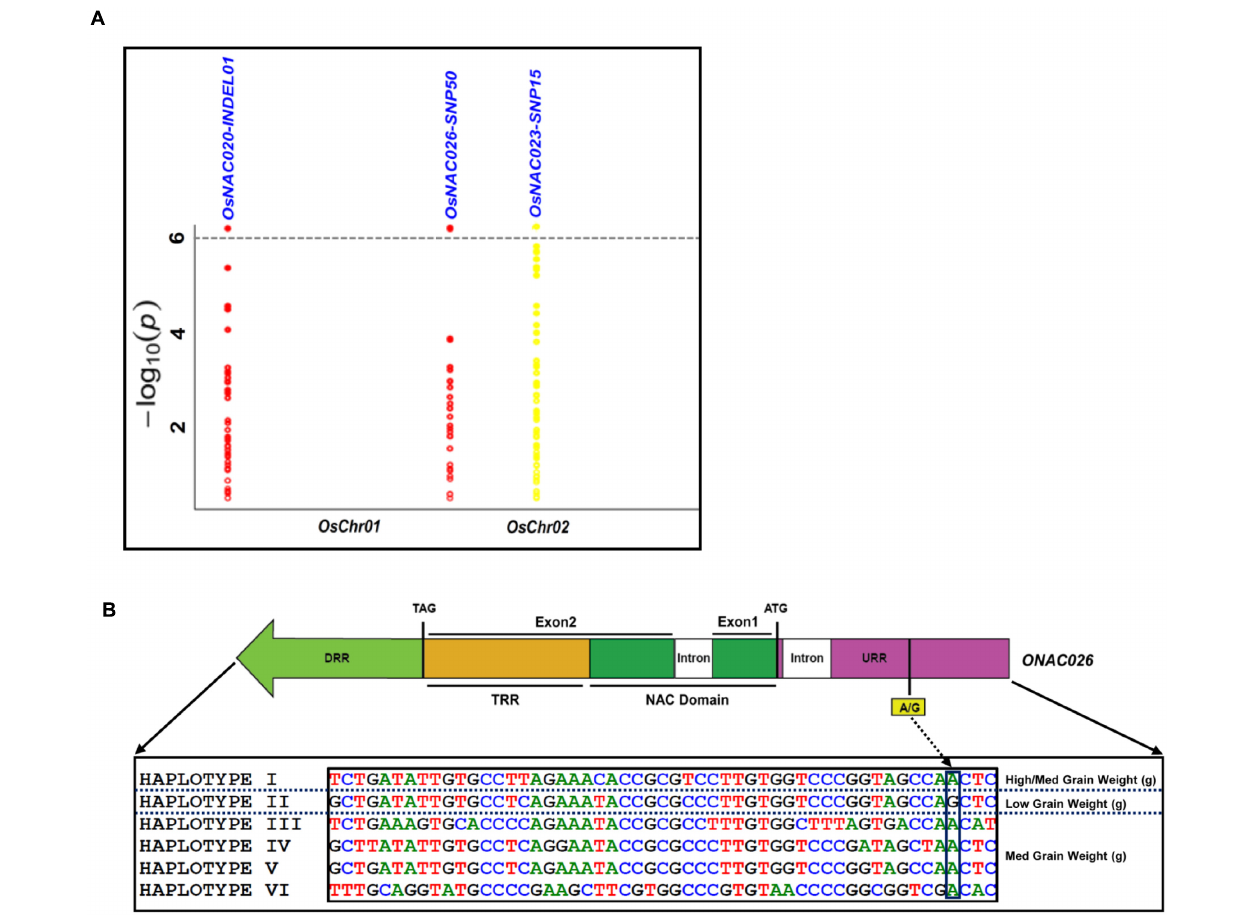
FIGURE 4 | Association of NAC genes with grain weight. (A) represents significance of the sequence variants identified for the NAC genes, for their association with grain weight trait by the Manhattan plot. The relative density of the sequence variants identified from the NAC genes are taken on the X-axis with their − log 10 (P) used for scanning the significant trait associated sequence variant on the Y -axis. (B) Validation of the strong association of the InDel in the URR of ONAC026 gene with the grain weight trait, where DRR and URR represent the downstream and upstream regulatory region respectively, ATG and TAG correspond to the translation start and stop codons respectively and TRR stands for the transcriptional regulatory region. The InDel clearly differentiates the six haplotypes into low grain weight and medium/high grain weight groups.